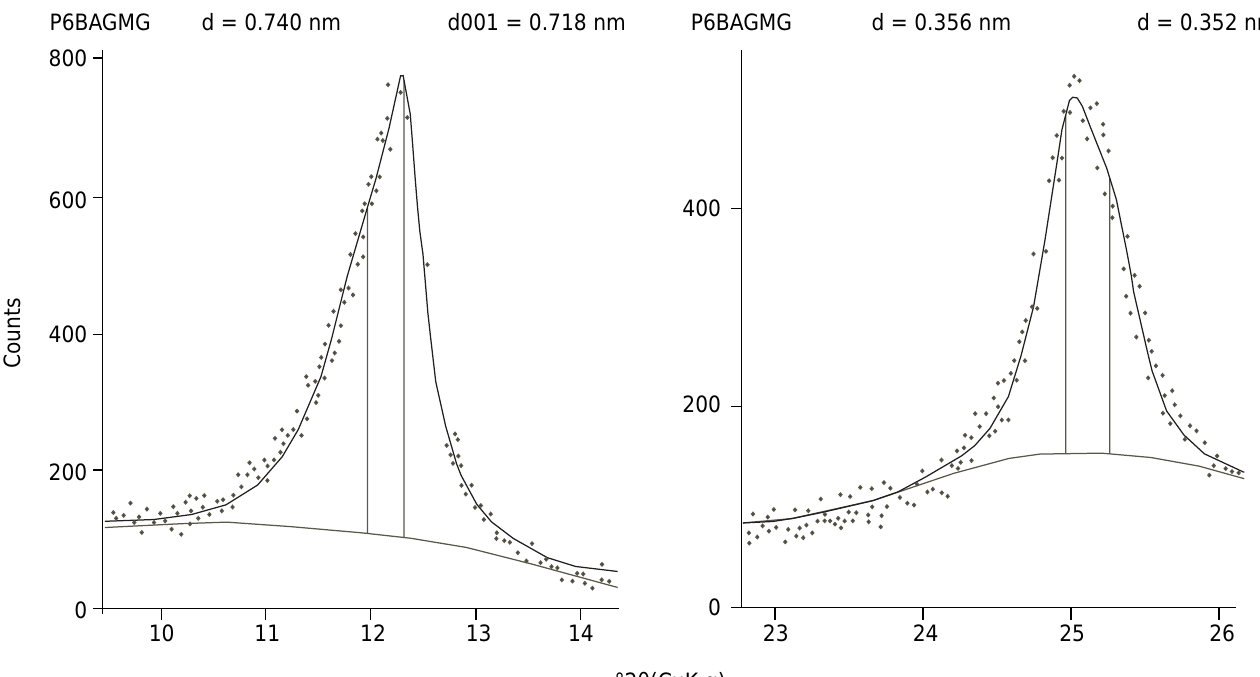
Figure 3. Automatic simulation of the shape of peaks in hkl 001 and 002 plans of “kaolinite” in the coarse clay sample from the B horizon of profile 6 [ Nitossolo Bruno (Oxisol), Painel, SC] with the use of HighScore Plus